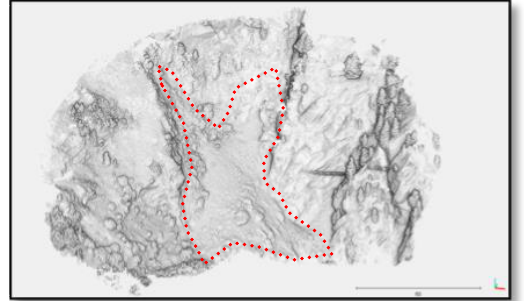
terrain and the difficult accessibility of the site, the images were taken ~100 m away from the modelled surface on a path facing the rockslide, over its middle section. Fifty-seven images were acquired with a 24mm focal-length lens, and 47 with a 105mm configuration (i.e. maximal zoom length), the latter acquisition focusing only on the upper part of the rockslide (Figure 3 and Figure 4).